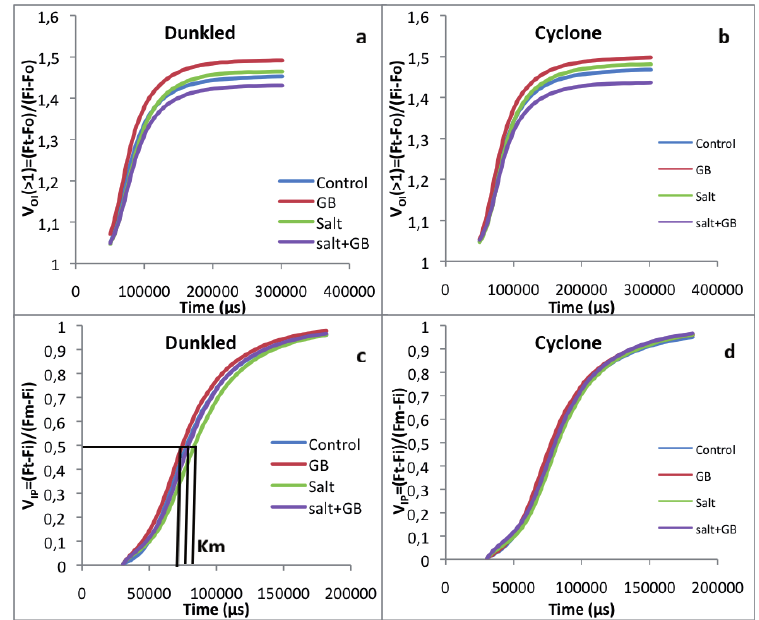
Fig. 5: VIP and VOI of two cultivars of canola ( Brassica napus L.) when three week old plants were subjected to foliar application of glycinebetaine and salt stress for further two